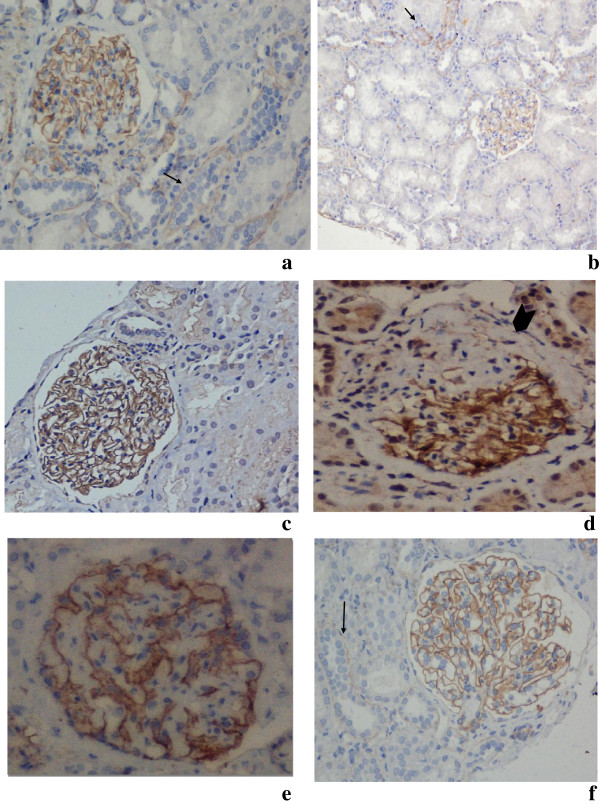
Photomicrograph shows beta dystroglycan expression (2+) in the glomeruli & tubules (arrows) a) Control (20X) b) MCD (10X) c) FSGS-normal glomerulus (20X) d) FSGS-loss of staining in sclerosed area (arrow head) (X40) e) IgAN (X40) f) MGN (20X) IHC, beta dystroglycan antibody.